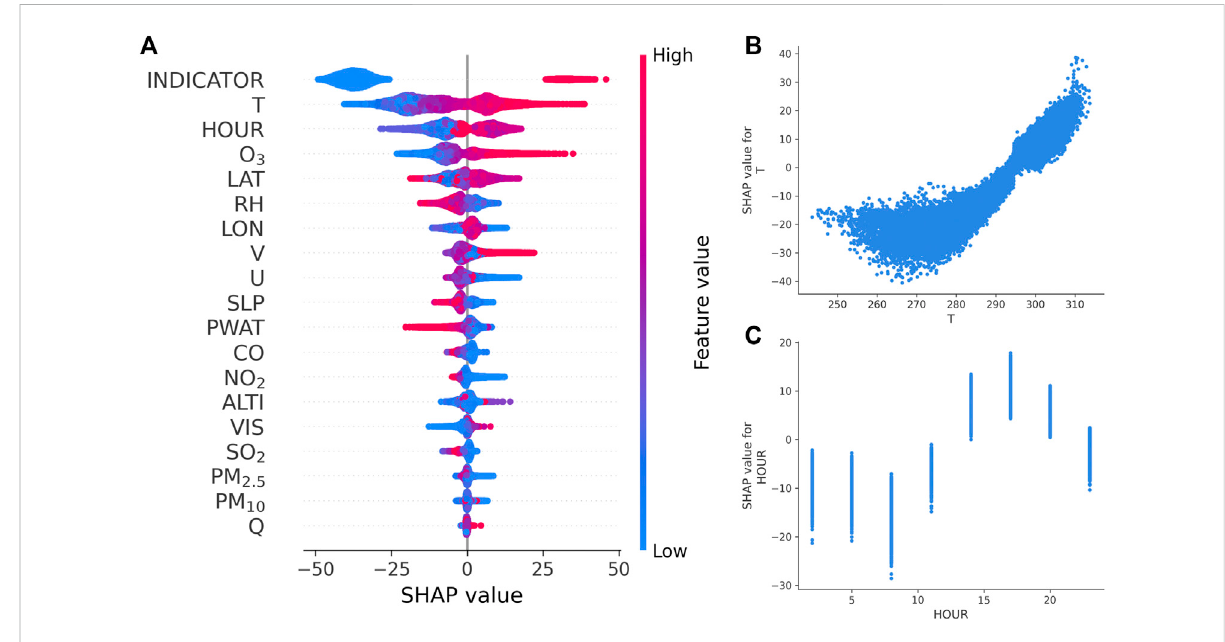
FIGURE 10 SHAP summary plot (A) , partial dependence plot of T (B) and partial dependence plot of HOUR (C) for the optimization of the 1st-day O 3